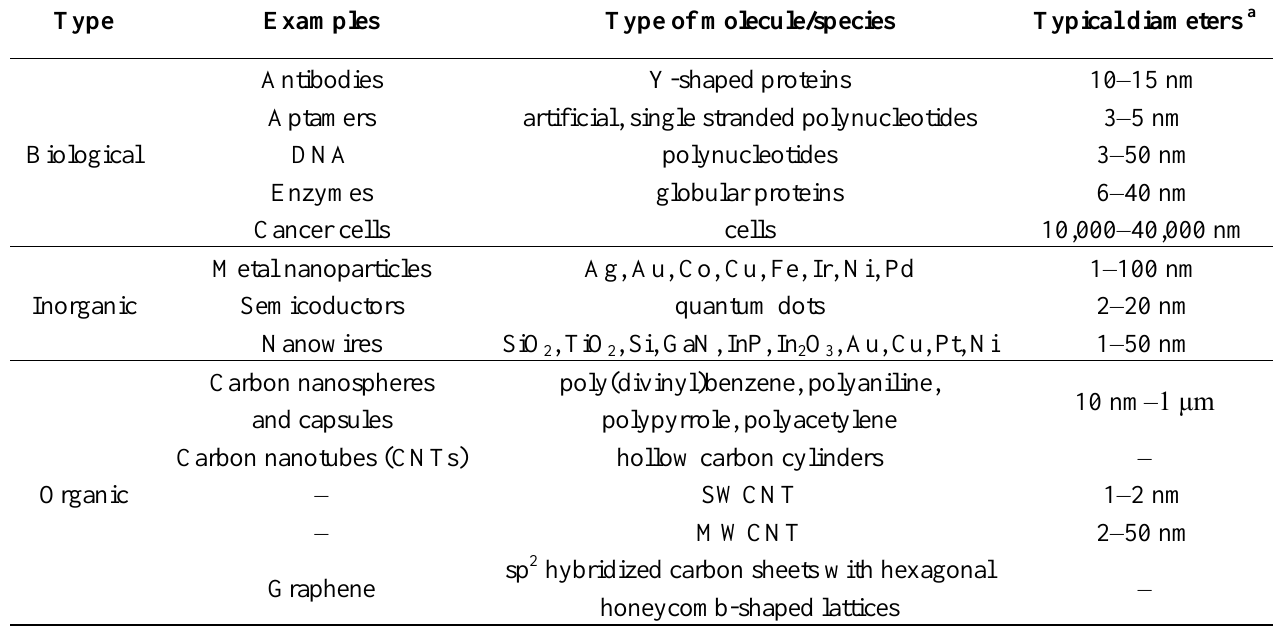
Table 1. Common nano- and